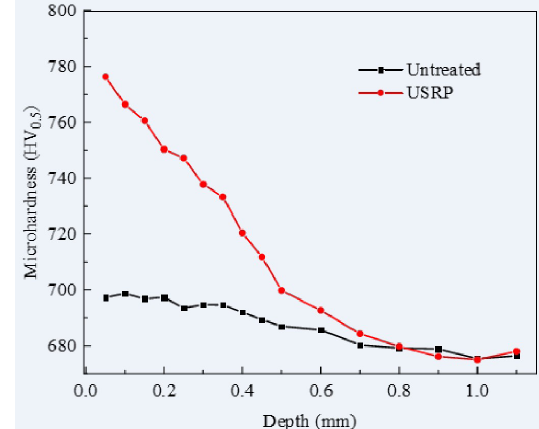
Figure 11. Cross-sectional hardness distribution of samples before and after USRP